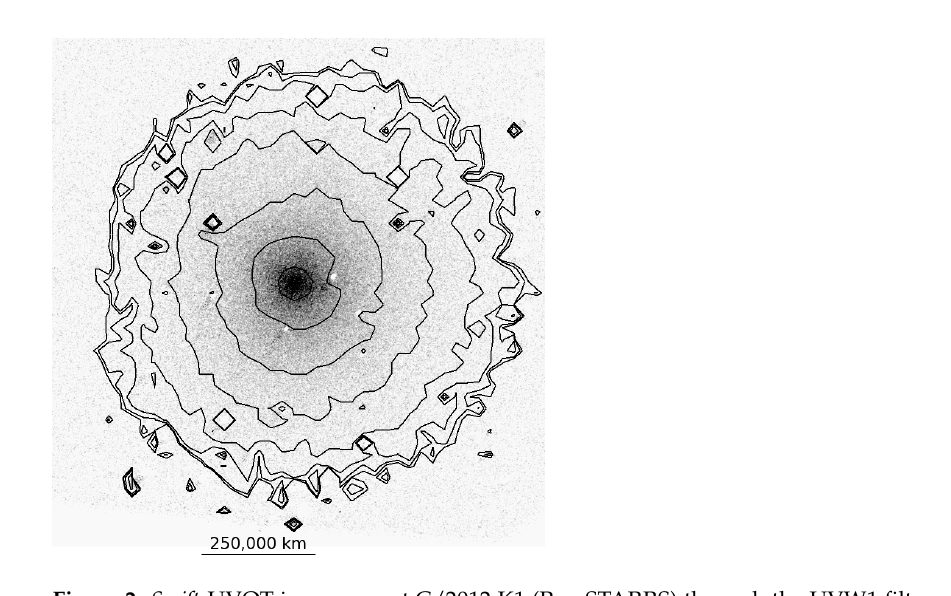
Figure 2. Swift -UVOT image comet C/2012 K1 (Pan-STARRS) through the UVW1 filter, after con- tinuum removal. A symmetric OH coma of 1 million kilometers across can be seen. The comet was approximately V = 11 mag at the time of the